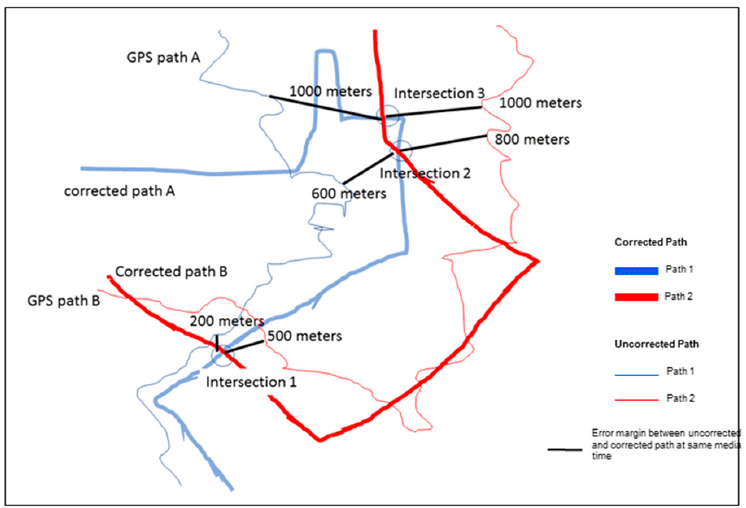
Figure 5. A conceptualization of the error between corrected and uncorrected coordinates for two different SV paths.